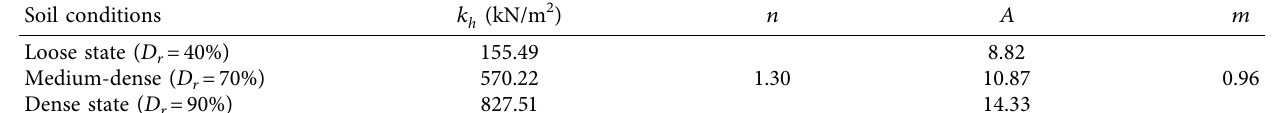
Table 5: Backcalculated subgrade modulus and curve-ftting parameters for static p - y curves. Soil conditions